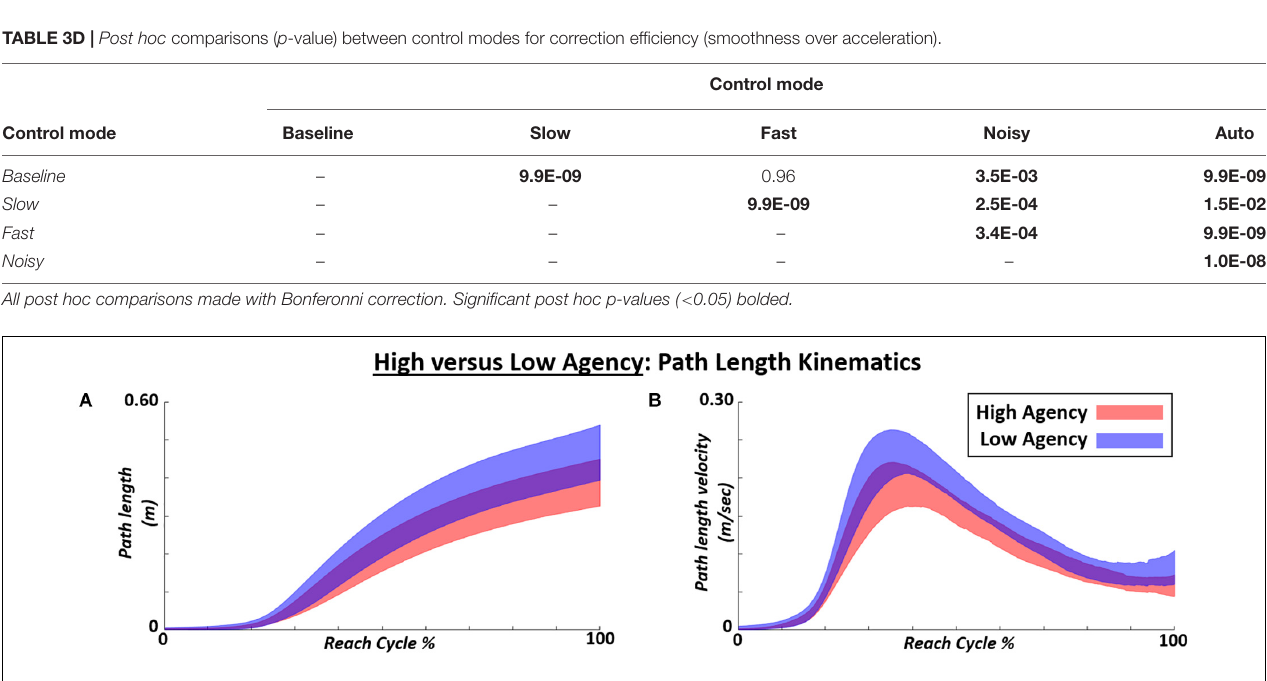
FIGURE 10 | Mean path length kinematics for position (m) and velocity (m/sec) shown for high implicit agency (top 50%) trials across all subjects and control modes versus low implicit agency (bottom 50%) trials. Kinematics presented as path length position (A) and velocity (B) across reach cycle%. Path length position and velocity plotted as mean +/–1 standard deviation varying across reach cycle for all participants